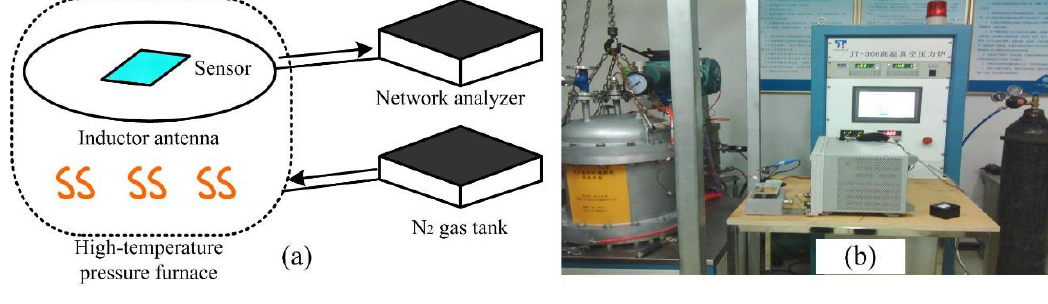
Figure 4. ( a ) Schematic and ( b ) physical diagrams of the high temperature/pressure complex measurement